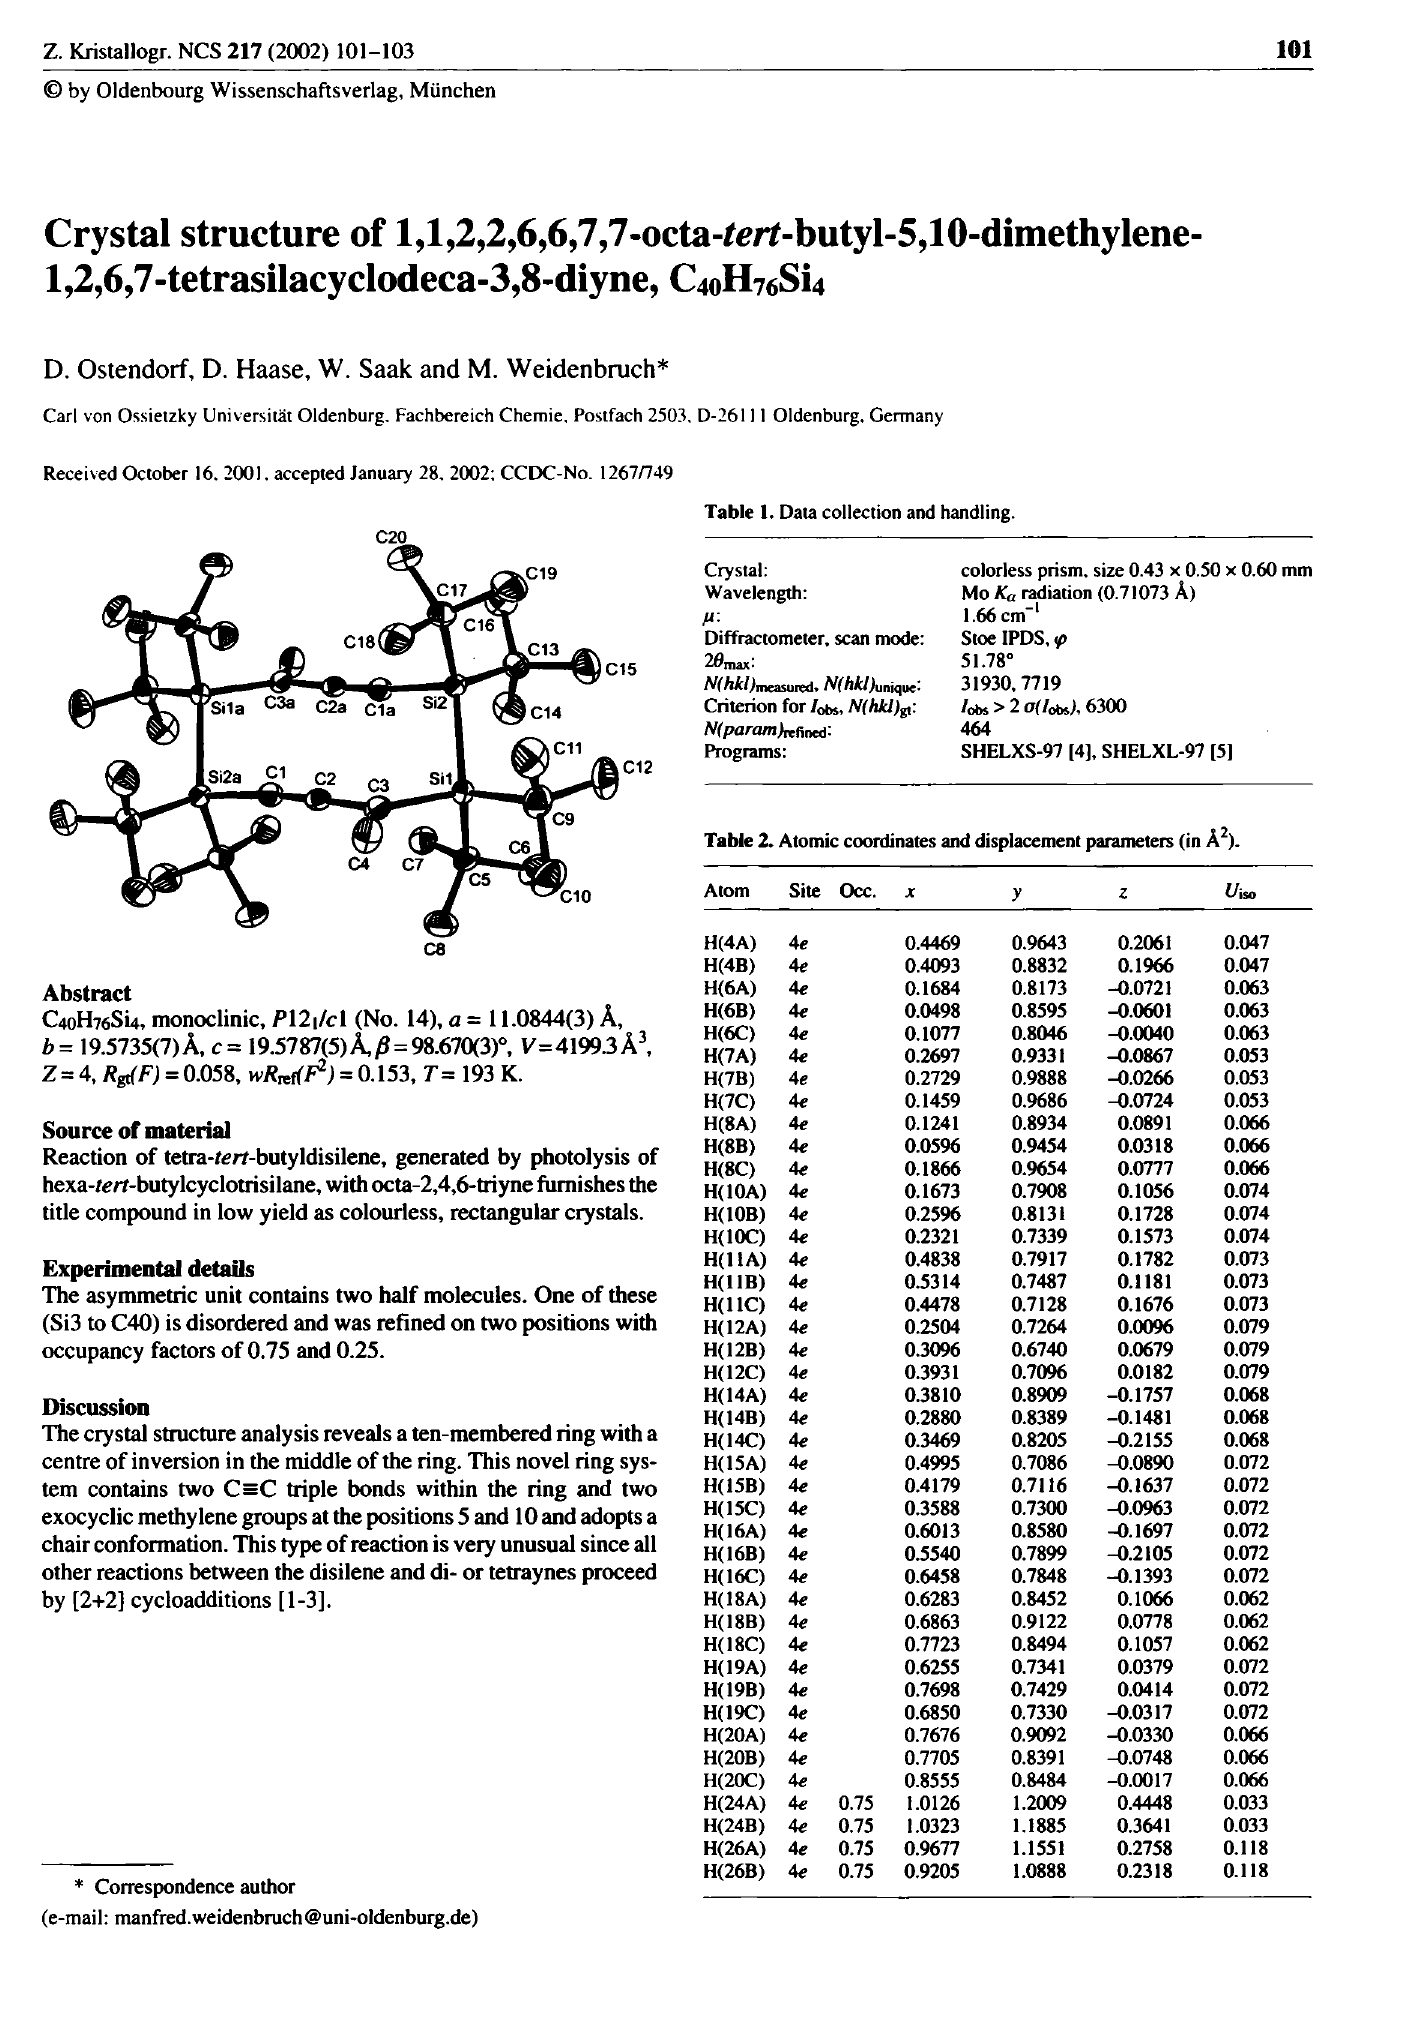
Table 1. Data collection and handling.